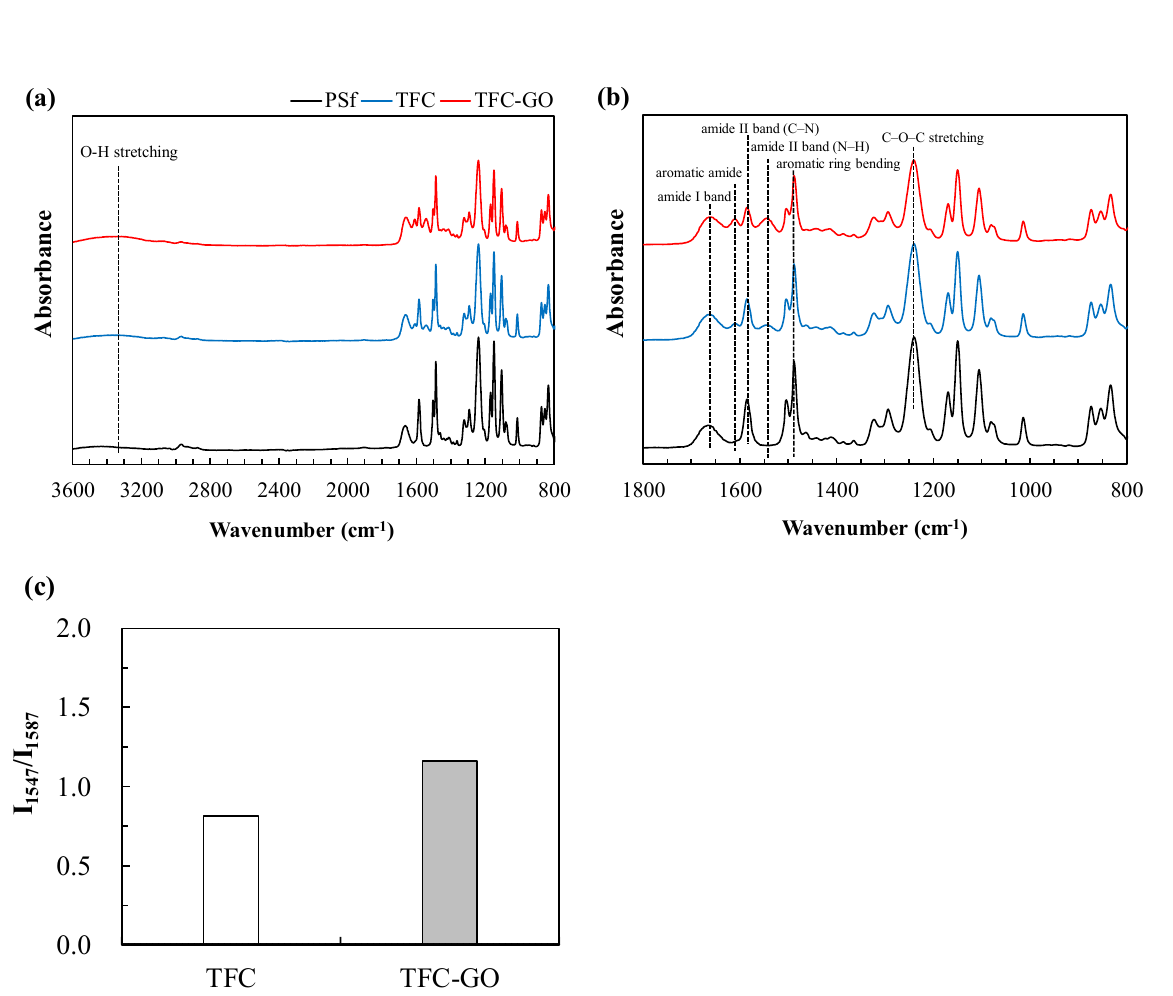
Figure 3. ATR-FTIR spectra of PSf, TFC, and TFC-GO membranes: ( a ) full scan with the wavenumbers in the range of 800–3600 cm − 1 , ( b ) zoom in with the wavenumbers in the range of 800–1800 cm − 1 , and ( c ) degree of grafting TFC and TFC-GO membranes.